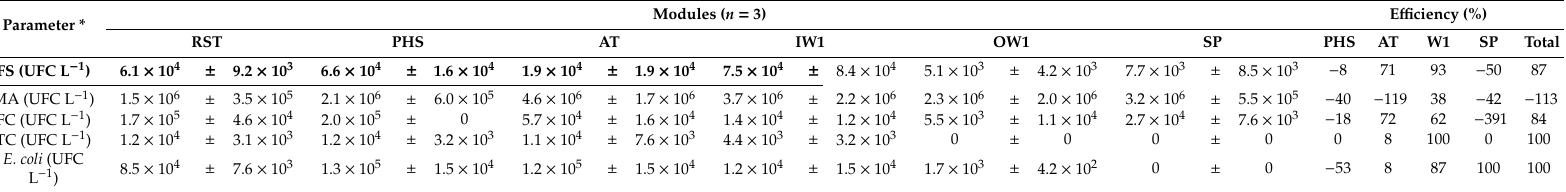
Table 3. Microbiological parameters and e ffi ciencies for each module on unplanted cell (W1). E ffi ciency is referred to a previous module and total e ffi ciency was calculated SP with respect to RST.